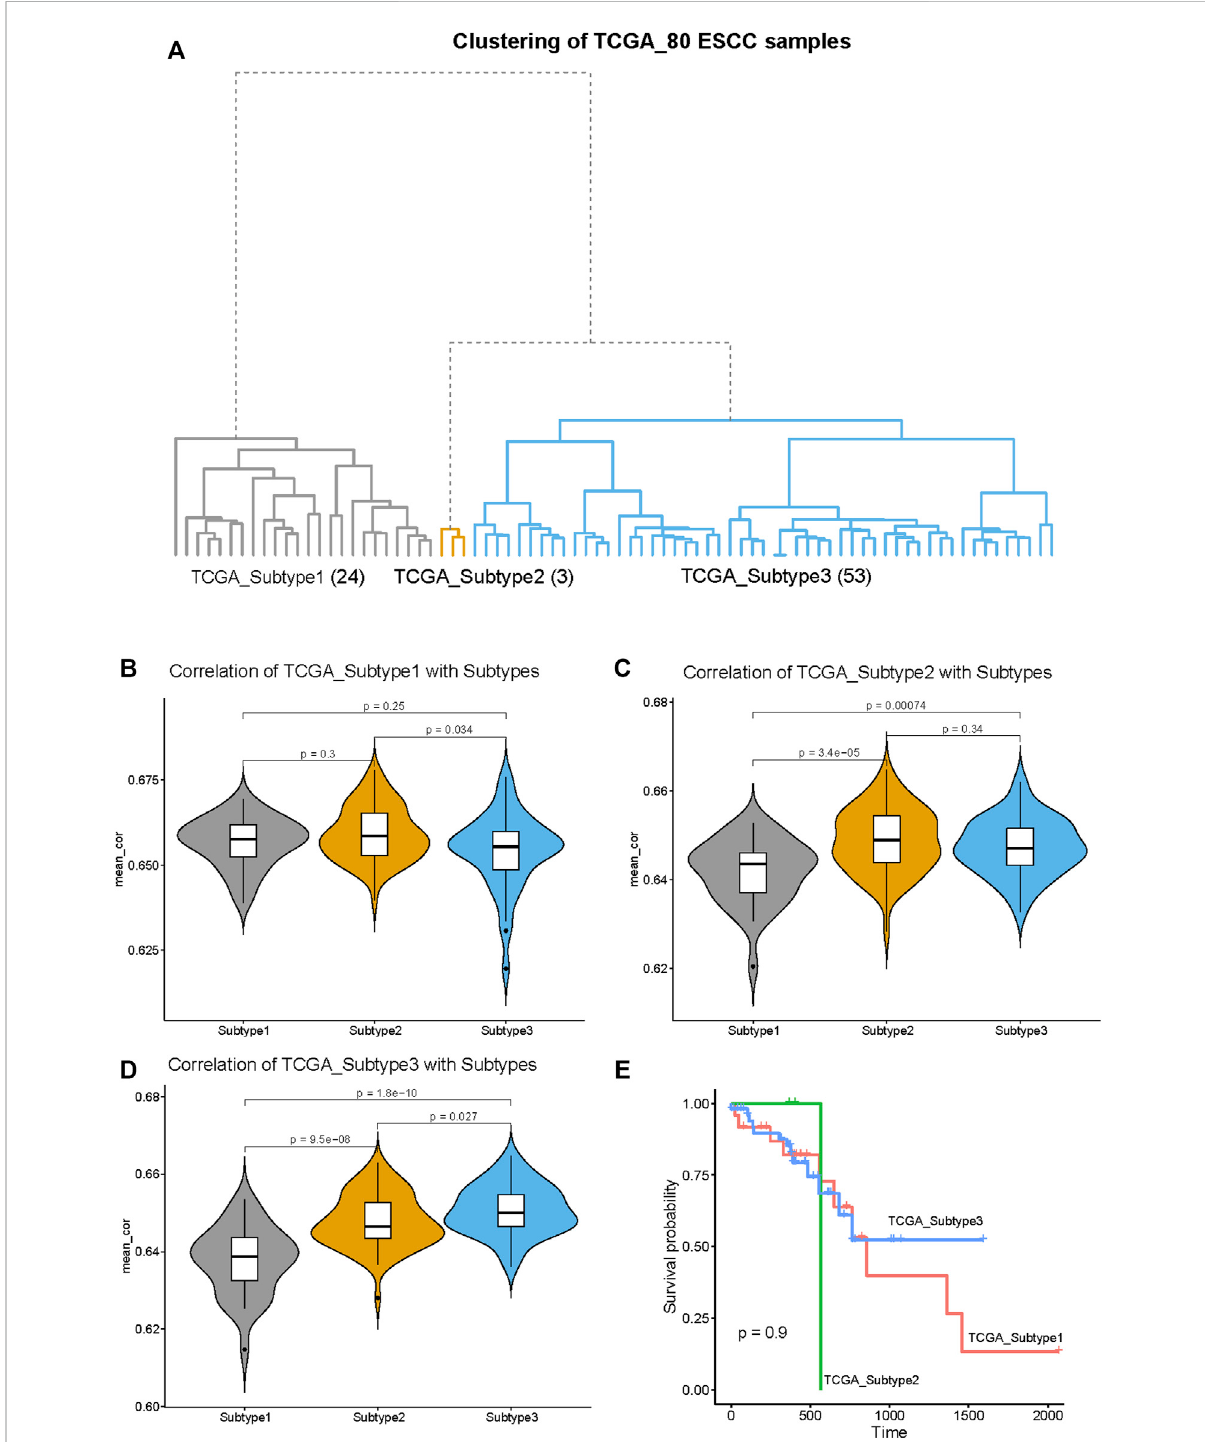
FIGURE 8 Validation of the generality of our ESCC Subtypes based on the RNA-seq data from TCGA database. (A) The hierarchical clustering tree of the 80 ESCC samples based on the RNA-seq data from TCGA database. The three subtypes are designated as: TCGA_Subtype1 (24 samples), TCGA_Subtype2 (3 samples), and TCGA_Subtype3 (53 samples). (B) The violin plot of the average correlation values between TCGA_Subtype1 and Subtypes (Subtype 1, Subtype 2 and Subtype 3). The average correlation values of TCGA_Subtype1 and Subtype 1 are signi fi cantly higher